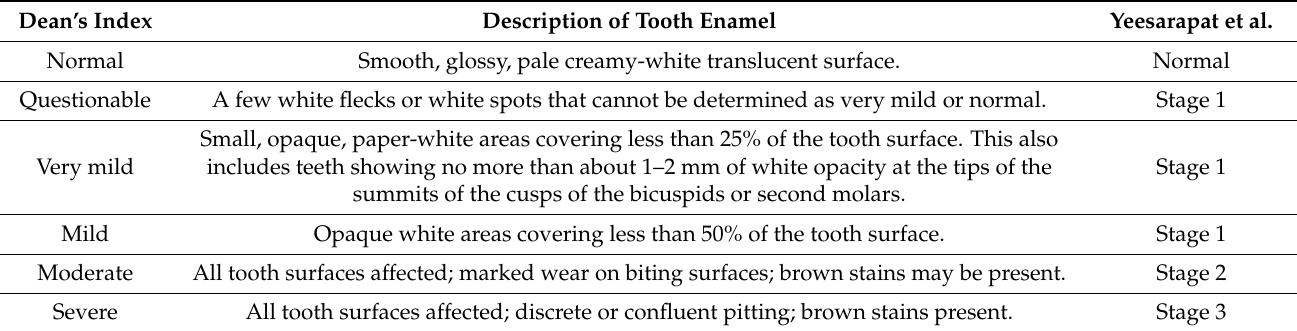
Table 1. Severity of dental fluorosis according to Dean’s index and Yeesarapat et al. [14]. Description of Tooth Enamel Yeesarapat et al.